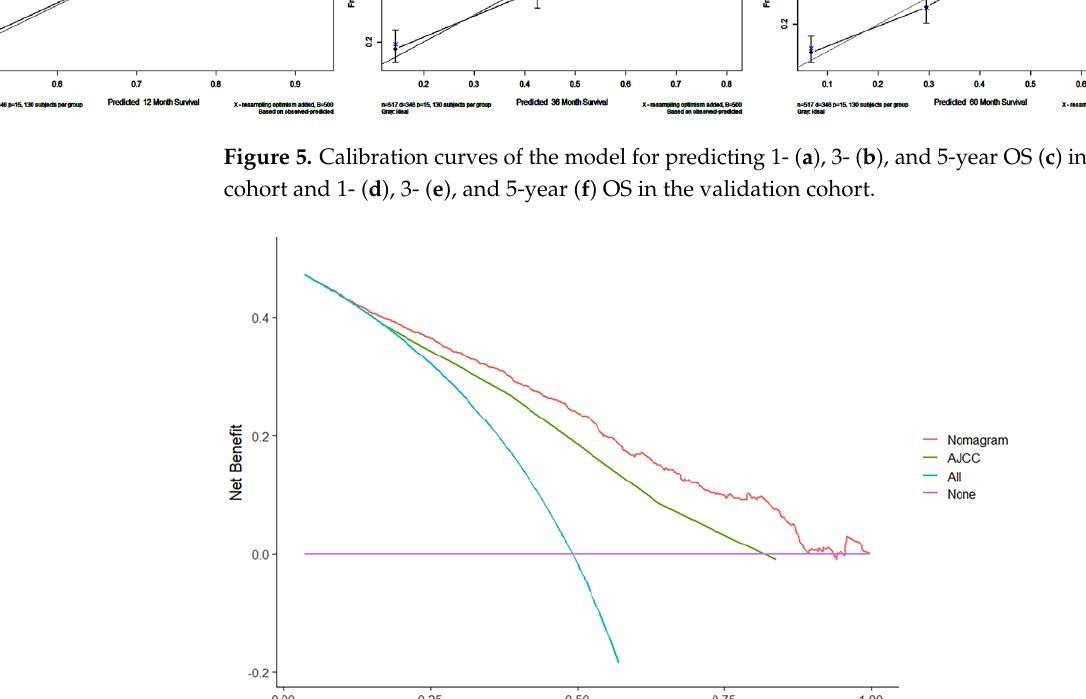
the optimal number of ELNs (n = 32) had better predictive ability than the XGBoost model excluding the optimal number of ELNs in predicting the OS rate at 1 (AUC: 0.803 vs. 0.753), 3 (AUC: 0.832 vs. 0.803), and 5 years (AUC: 0.806 vs. 0.792). Figure 6. Decision curve analysis for the nomogram.